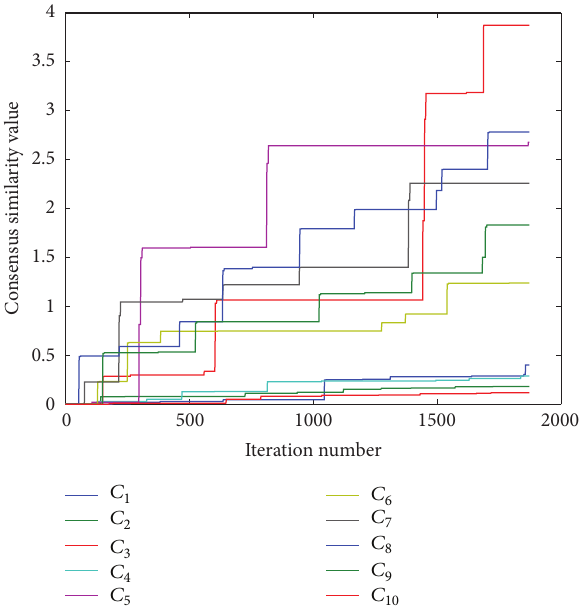
Figure 10: The discrepancy history of various configurations of the circuit.